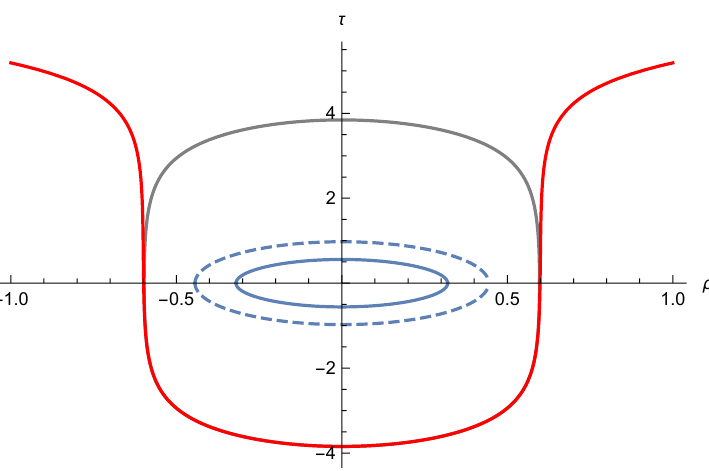
Figure 4 . 3-brane embeddings in the wormhole with torus cross-section and β 1 = β 2 (upon rescaling τ → τ ). The innermost solid loop is the trajectory of the D 3 -brane instanton, with x = 1 . The βb dashed loop indicates the trajectory for a toy model of a 3-brane with a mass-to-charge ratio 1 . 15 , the outermost loop is the trajectory for the toy model with mass-to-charge ratio x = 1 . 19967 , just below the critical value of x 0 = 1 . 19967864 . . . The red line is the trajectory when x = 1 . 19968 , just above the critical